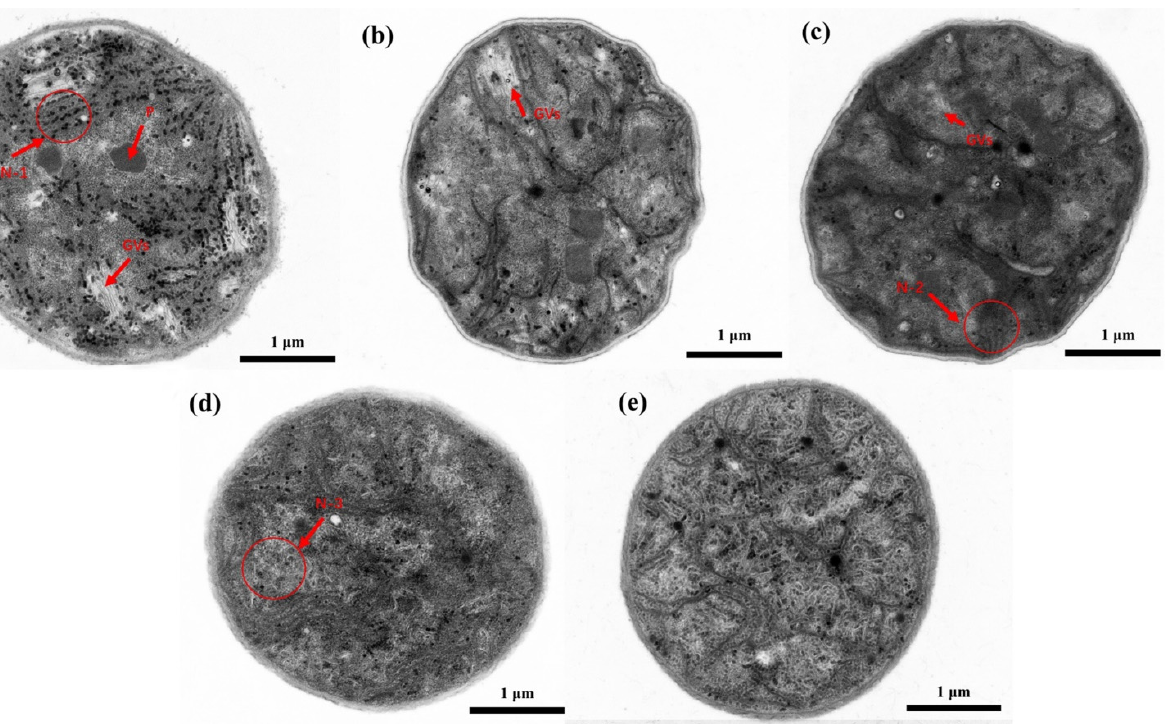
Figure 3. TEM images of Microcystis cells with different ST times, ( a ) 0 s; ( b ) 20 s; ( c ) 40 s; ( d ) 60 s; ( e ) 80 s. GVs, gas vesicles; C, cyanophycin granule; N-1, the attached phycobilisomes on the photosynthetic lamellae; N-2, the blurred and fractured photosynthetic lamellae; N-3, the converged intracellular structures.